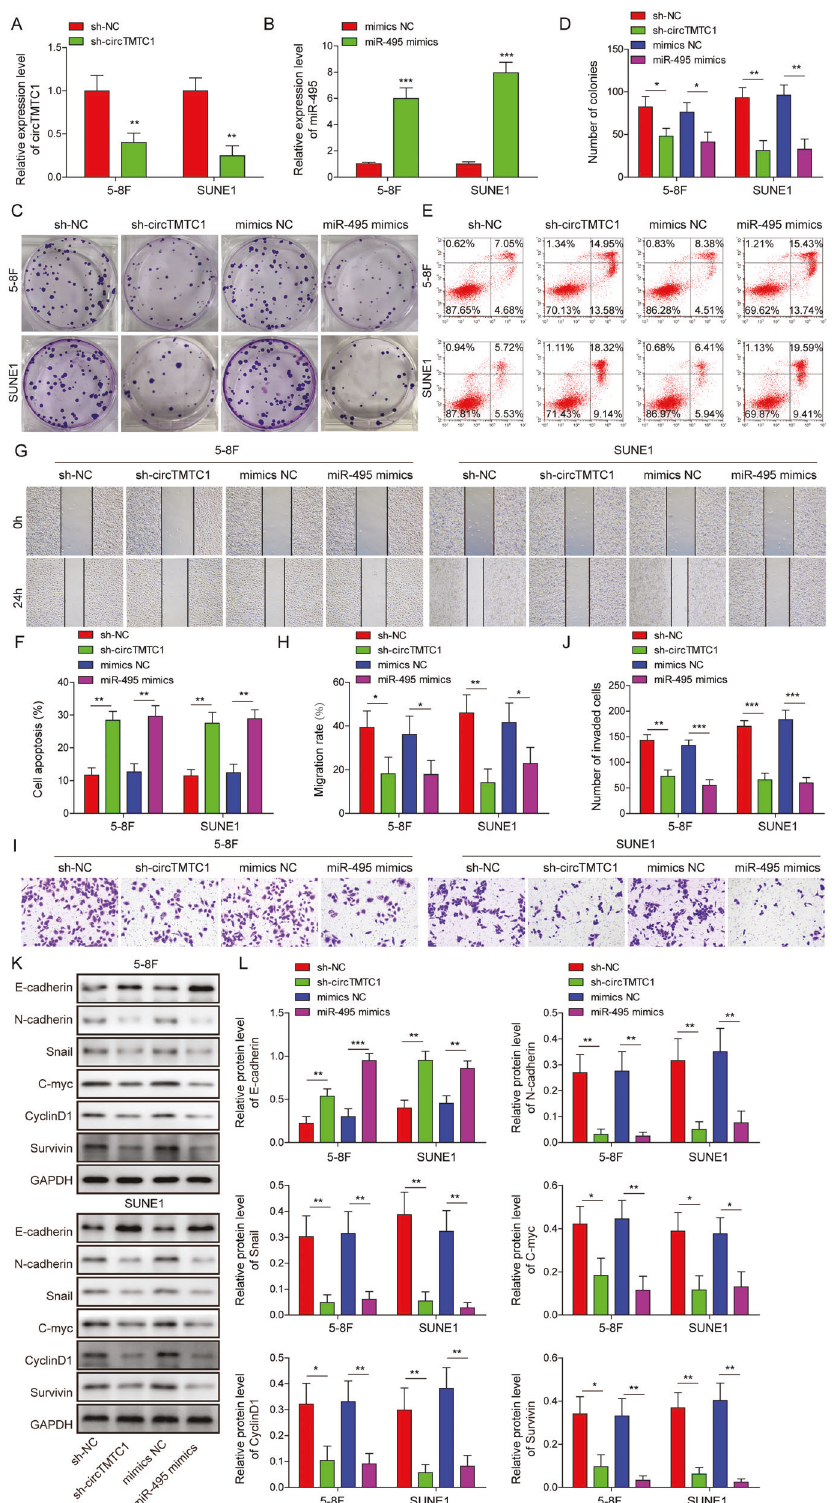
Fig. 2 CircTMTC1 knockdown and miR-495 overexpression suppressed NPC malignant phenotypes and enhanced cell apoptosis. 5 – 8 F and SUNE1 cells were transfected with sh-NC, sh-circTMTC1, mimics NC or miR-495 mimics respectively. A , B The relative expression of circTMTC1 and miR-495. Data from three independent experiments were normalized to GAPDH or U6 snRNA respectively. C , D Colony formation analysis of NPC cells. E , F Cell apoptosis analysis by fl ow cytometry. Scratch wound healing ( G , H ) and transwell invasion ( I , J ) analysis for 5 – 8 F and SUNE1 cells. K, L The expression of E/N-cadherin, Snail, c-Myc, Cyclin D1, and Survivin. * P < 0.05, ** P < 0.01, and *** P < 0.001.